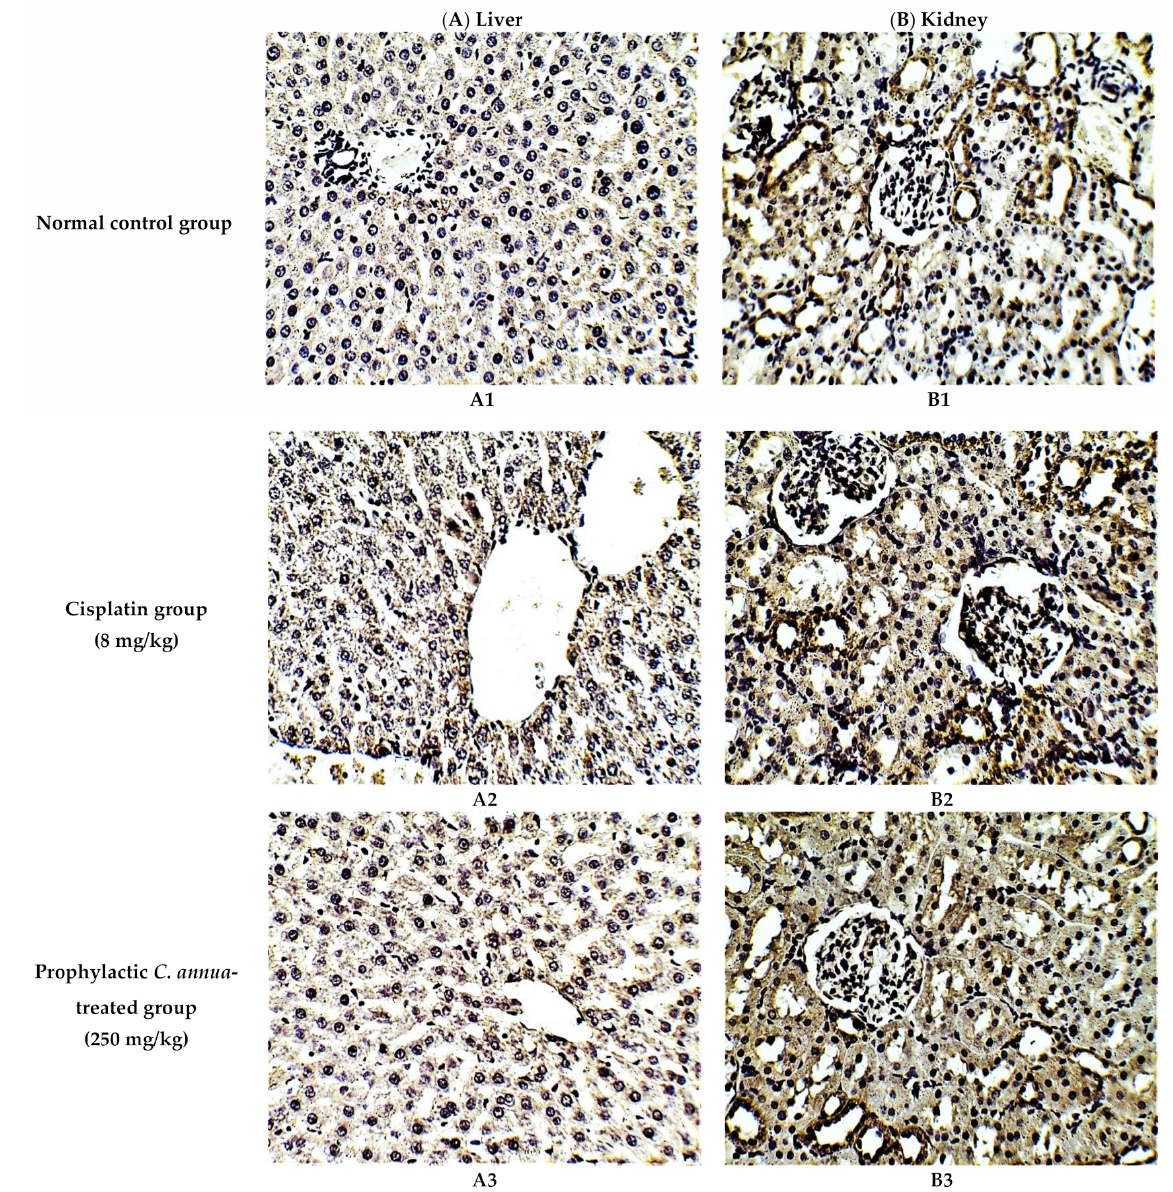
Figure 3. Representative photomicrographs ( × 400) of immuno-histochemical staining of IL-1 β in liver ( A ) and kidney ( B ) tissues of the experimental groups. ( A1 ) liver tissues of normal control group, ( A2 ) liver tissues of cisplatin group, ( A3 ) liver tissues of Prophylactic C. annua - treated group, ( B1 ) kidney tissues of normal control group, ( B2 ) kidney tissues of cisplatin group, ( B3 ) kidney tissues of Prophylactic C. annua - treated